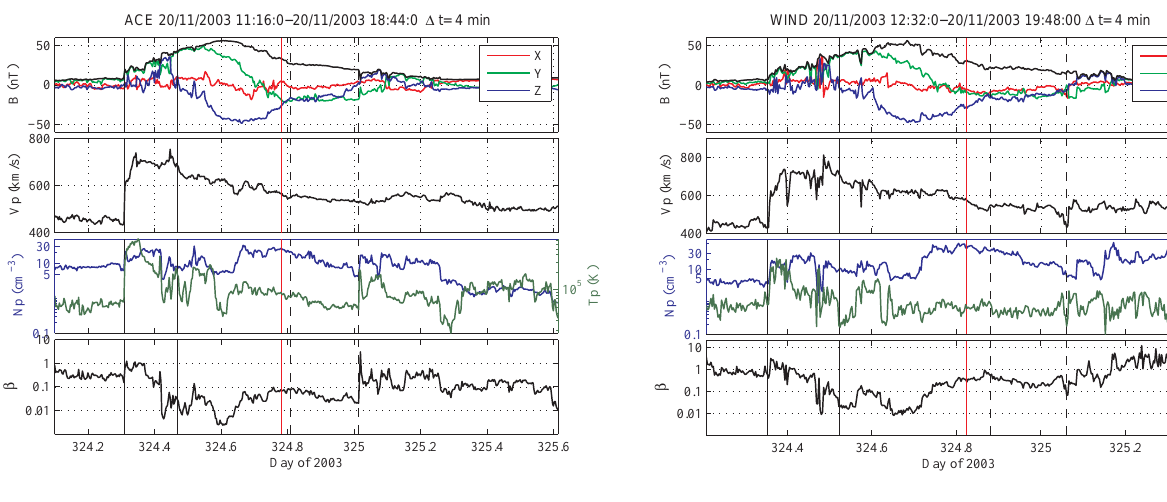
Fig. 8. Data from the ACE spacecraft, from top to bottom: Magnetic field components (coloured as indicated) and absolute value (black line), proton bulk velocity, proton number density and temperature as well as proton β (ratio of plasma to magnetic pressure). The first vertical solid line indicates the shock, and the second and third the final GS-reconstruction interval. Dashed vertical lines are the boundaries of the back region.